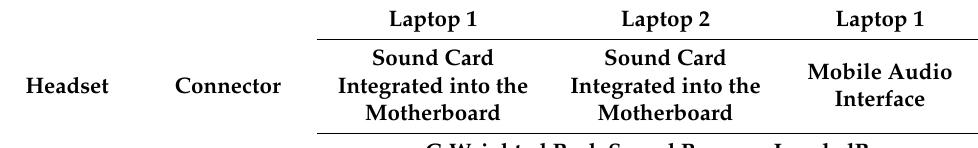
Table 3. Values of C-weighted peak sound pressure level of the test signal reproduced by various headsets that are directly connected to a Laptop 1 and a Laptop 2, and to a Laptop 1 through a mobile audio interface.